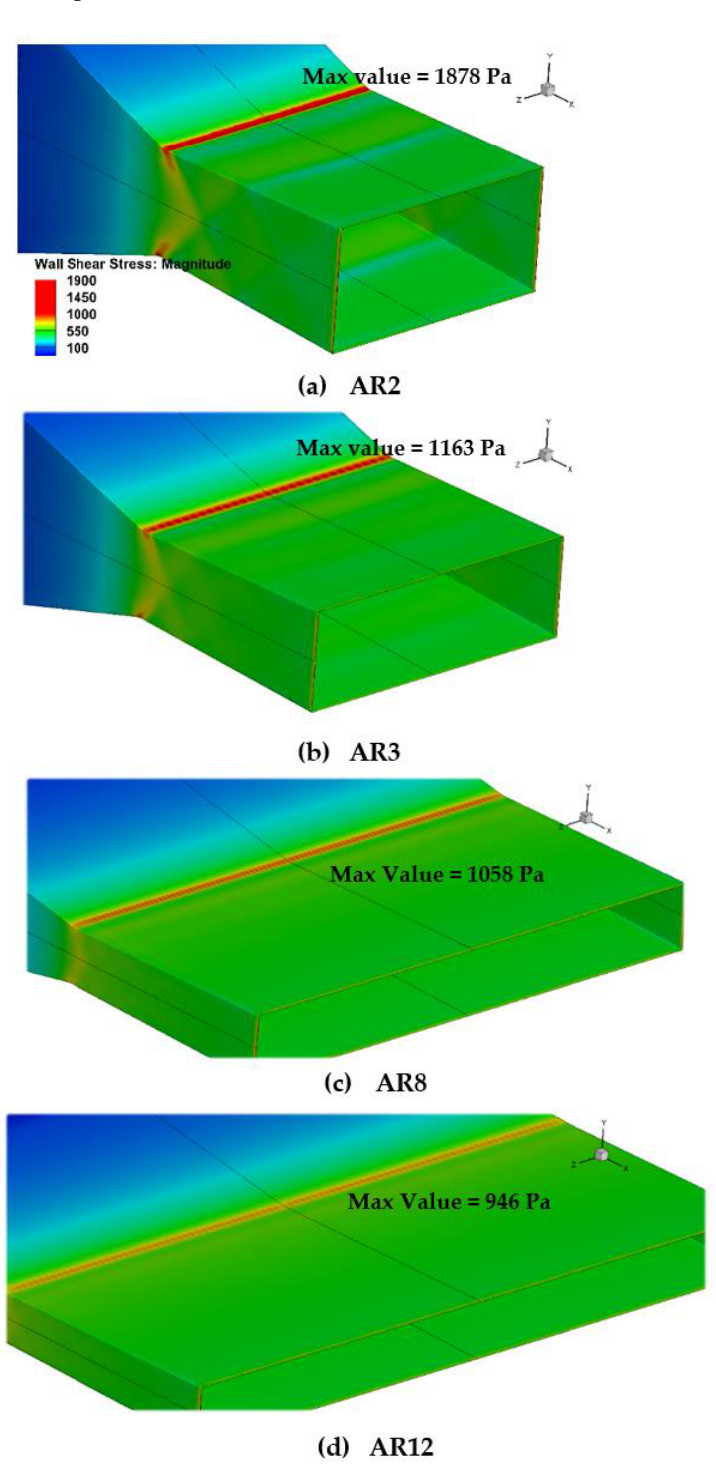
Figure 6. Contours of wall shear stress (Pa) zoomed in at the nozzle throat ( a ) AR2, ( b ) AR3, ( c ) AR8, ( d ) AR12 (the contour plot range is adjusted for better visualization).